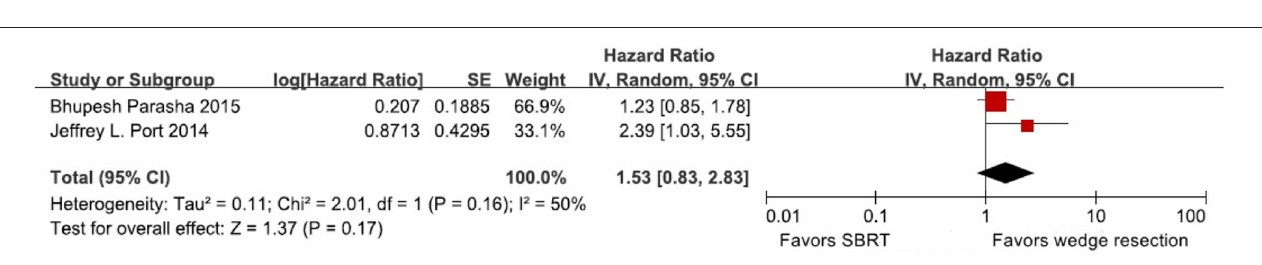
FIGURE 3 | Forest plot of 5-year DFS in patients treated with wedge resection compared with SBRT. CI, confidence interval; DFS, disease-free